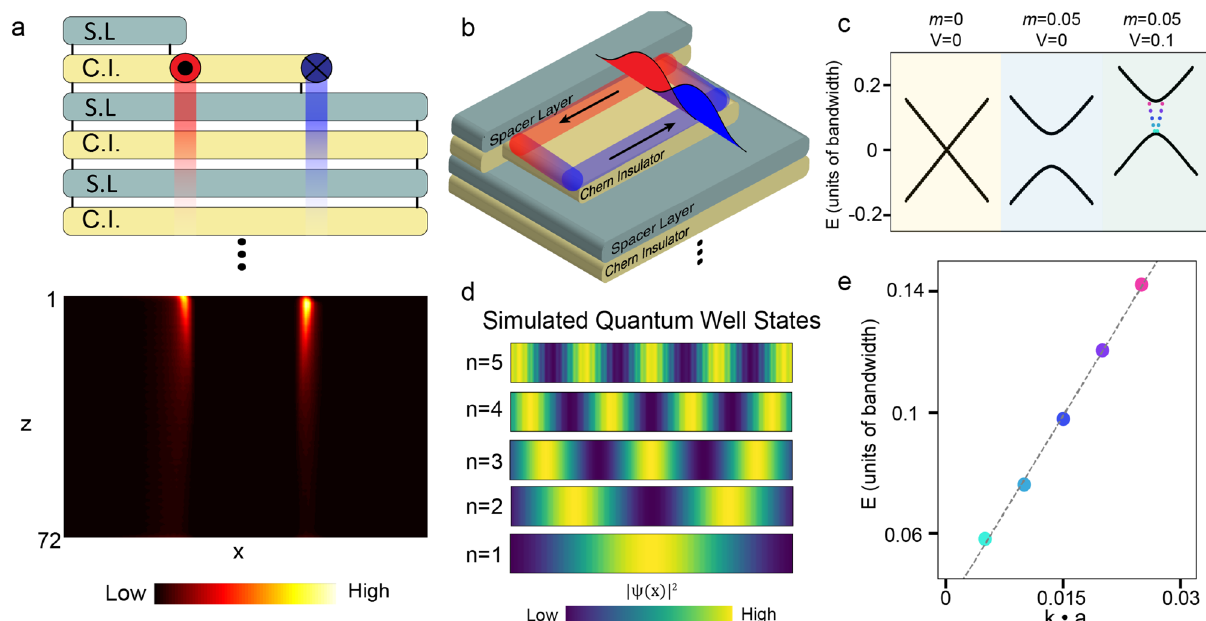
Fig. 4 Tight binding calculation of linearly dispersing states within a potential well. a Schematic of coupled Chern insulator layers (C.I.) with alternating spacer layers (S.L) , with a Chern insulator terrace (top panel), a simple stack that mimics our geometry. The red and blue circles indicate 1D chiral modes traveling out of and into the page, respectively, with the red and blue trails indicating their power-law decay into the bulk. The bottom panel is a numerical simulation of 70 full Chern insulator layers plus two partial layers as shown in the top panel. The bright regions in the bottom panel show the numerically calculated chiral edge states on the exposed terrace and their decay into the bulk. b Schematic of the narrow, con fi ned Co 3 Sn terraces. The exposed Chern insulator layer (Co 3 Sn plane) hosts chiral edge states, and when the terrace is suf fi ciently narrow, the two counterpropagating states will overlap and interact, as shown by the red and blue curves. c Low energy dispersion for different parameters of m and V . With no mixing or potential well, two linearly dispersing bands cross at zero momentum (light yellow left panel). Adding a mixing term of fi ve percent of the bandwidth, a gap opens as the two bands hybridize (light blue middle panel). Further adding the potential of ten percent of the bandwidth increases the energy of all states and causes fi ve states to be con fi ned entirely within the potential well (light green right panel), indicated by the colored dots within the gap. d Wavefunctions of the con fi ned, linearly dispersing states shown in e . e Dispersion of the states con fi ned within the potential well from the light green panel in c . A straight dashed line is provided as a guide to the